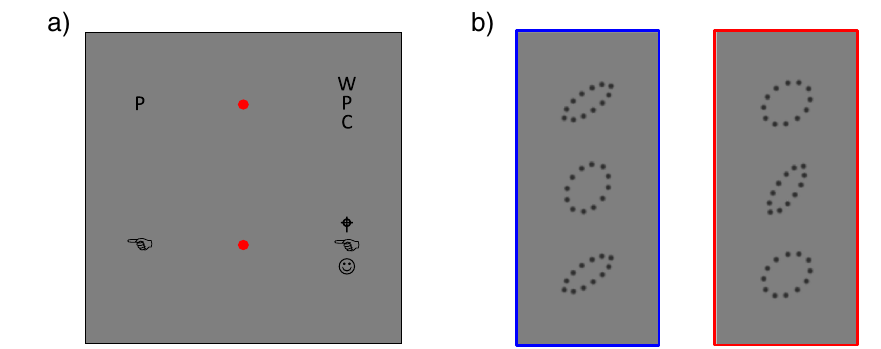
conditions were tested: a rounded target with elongated fl ankers (Low reliability target, high reliability fl ankers, blue at left) or an elongated target with rounded ovals (red at right). In the main condition the centre-to-centre distance of fl ankers and targets was 5.5deg, and eccentricity 26 degrees, leading to a Bouma ratio of